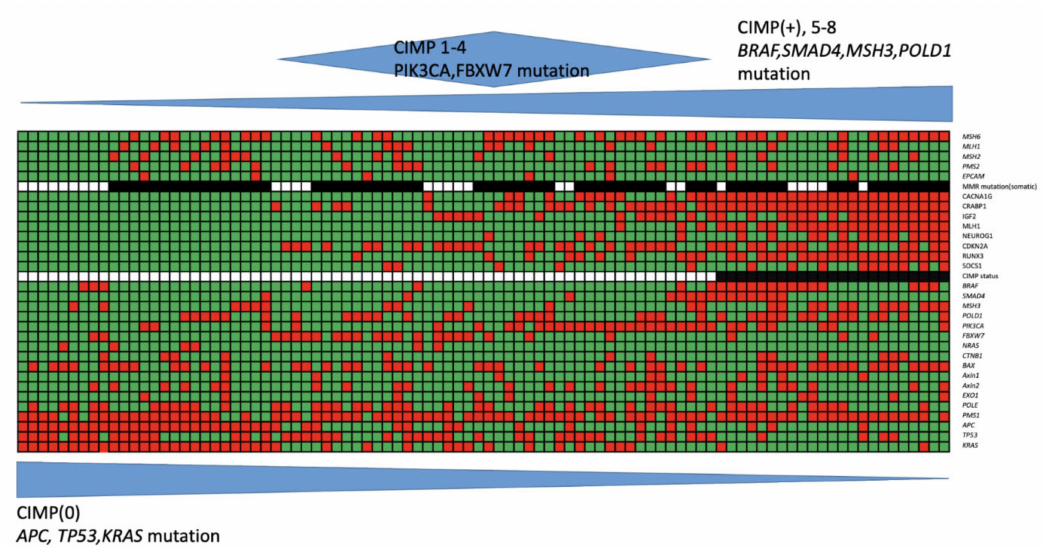
Figure 1. The mutational profiles in microsatellite instability (MSI)-high colorectal cancer (CRC) with 5 (cid:48) -C-phosphate-G-3 (cid:48) island methylator phenotype CIMP-high, CIMP-low, and CIMP-0 CRCs. Green field: genetic mutation ( − ); red field: genetic mutation ( + ); white field: MMR mutation ( − ) or CIMP − ; black field: MMR mutation ( + ) or CIMP + ; blue field: rate of genetic mutation.